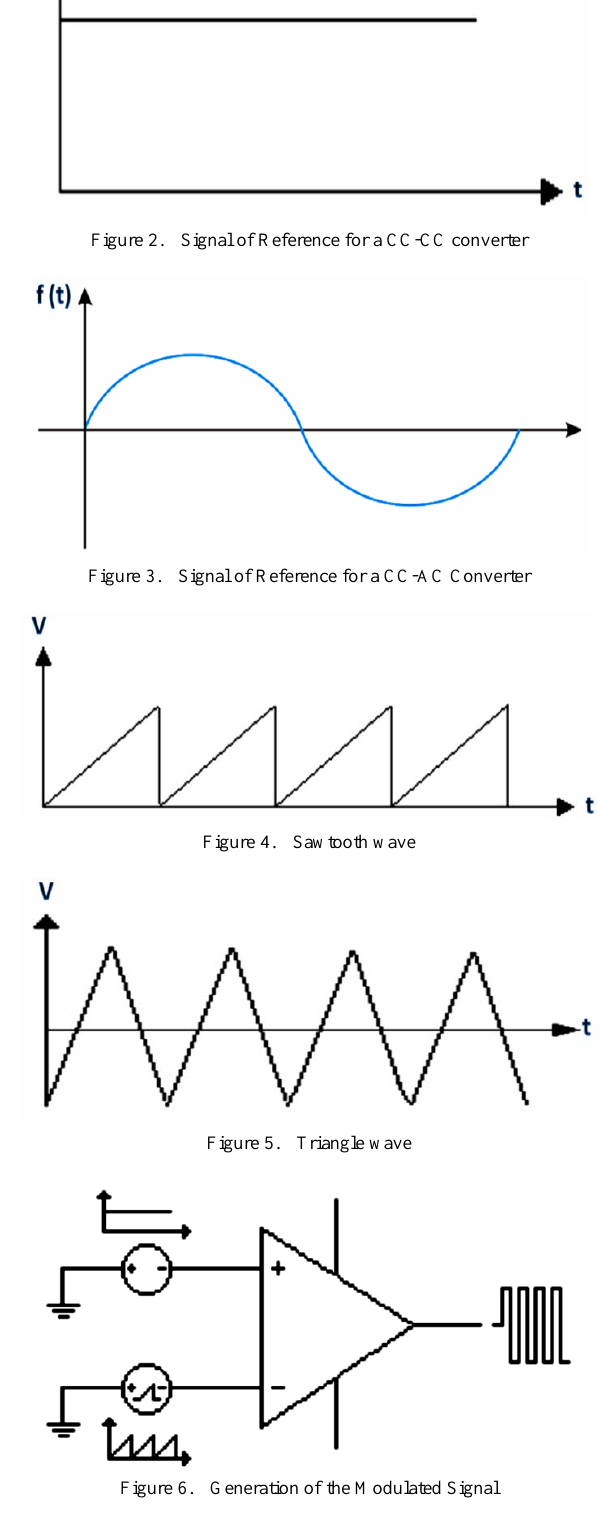
Figure 6. Generation of the Modulated